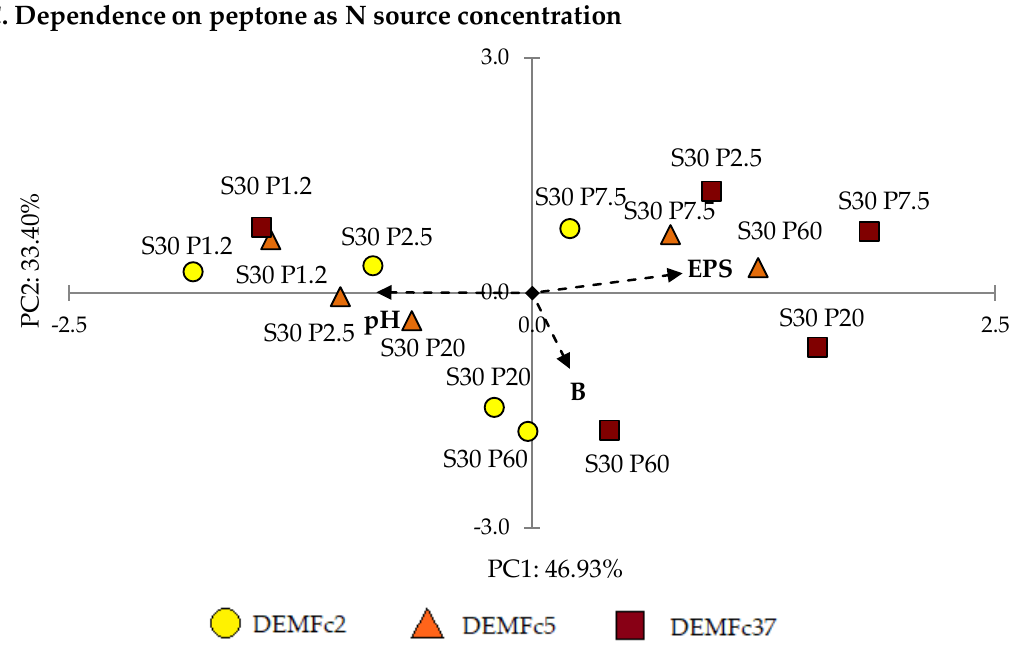
Figure 7. PCA-dependence of EPS concentrations (EPS), fungal dry biomass (B), and pH values in post-culture liquid on: ( A ) C and N source type, ( B ) sucrose concentration (g/L), ( C ) peptone